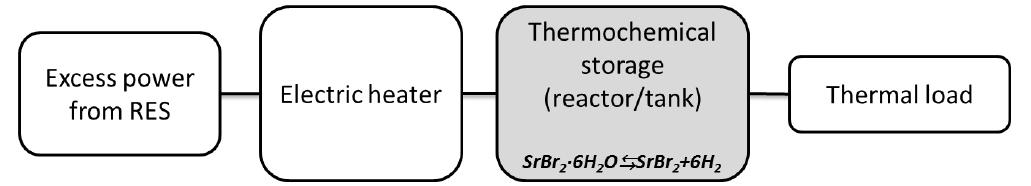
Figure 5. PtH / TCTES system developed by Cammarata et al. [139]. Figure 5. PtH/TCTES system developed by Cammarata et al. [140]